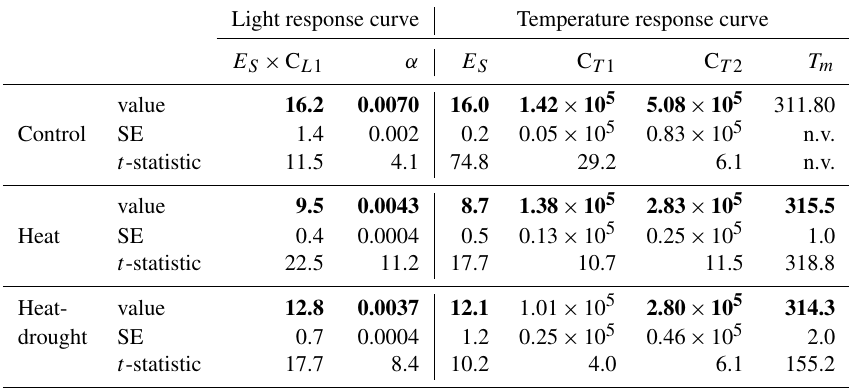
Table 4. Parameters E S × C L 1 ( E S being the isoprene emission factor at standardized conditions and C L 1 a dimensionless scaling parameter) and α including their corresponding standard errors and the t -statistic for the optimized light response curve of the control heat and heat– drought trees at a standard temperature of 30 ◦ C. The parameters E S (nmolm − 2 s − 1 ), C T 1 (Jmol − 1 ), C T 2 (Jmol − 1 ) and the temperature optimum of isoprene emissions T m (K) (with corresponding standard errors SE and t -statistic) derived for the temperature response curve at a standard photosynthetically active radiation of 500µmolm − 2 s − 1 are shown in an analog manner. Values with a p ≤ 0.05 are given in